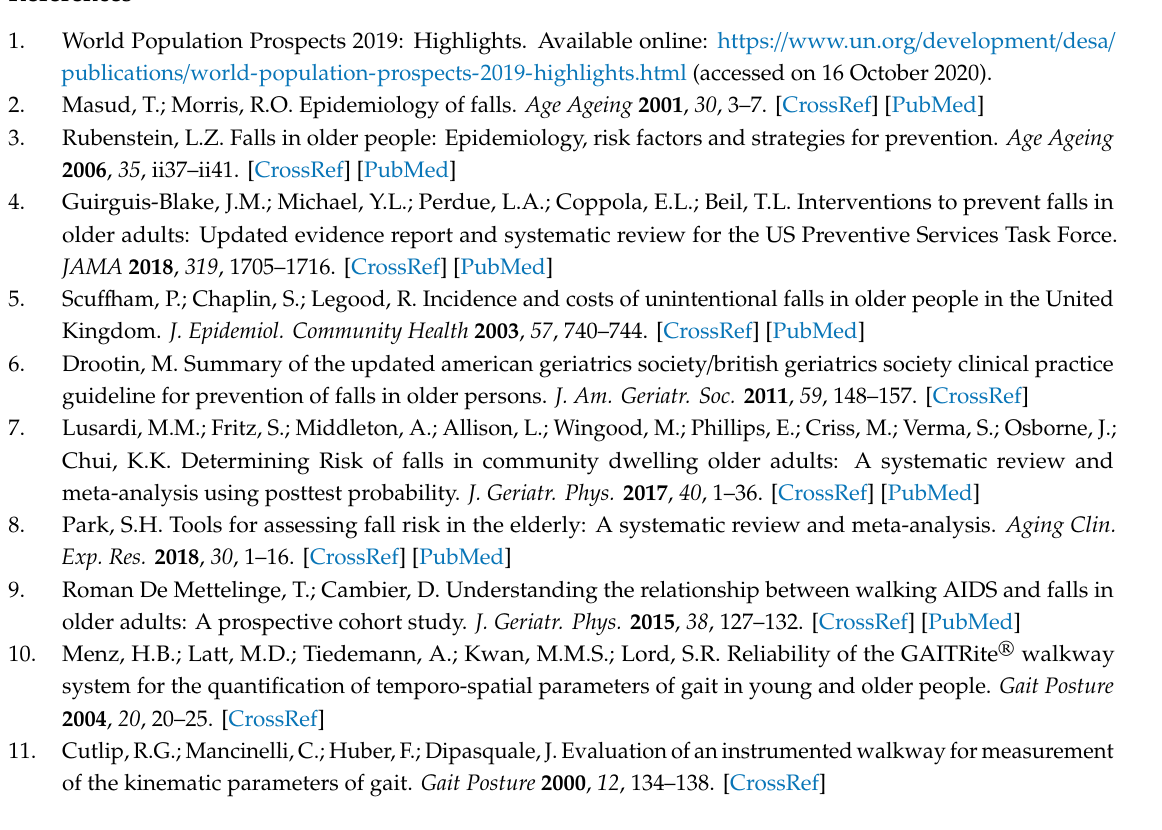
Figure S1: Correlation between GAITRite parameters and functional balance tests in patients not using walkers. Blue represents positive correlations, and red represents negative correlations. Color saturation and dot sizes represent correlation strength. Abbreviations: BBS, Bergs Balance Scale; DGI, Dynamic Gait Index; TUG, Timed Up and Go; STS, Sit To Stand test. Table S1: Correlation values between GAITRite parameters and functional balance tests in all patients. Abbreviations: BBS, Bergs Balance Scale; DGI, Dynamic Gait Index; TUG, Timed Up and Go; STS, Sit To Stand test. Table S2: Correlation values between GAITRite parameters and functional balance tests in patients using walkers. Abbreviations: BBS, Bergs Balance Scale; DGI, Dynamic Gait Index; TUG, Timed Up and Go; STS, Sit To Stand test. Table S3: Correlation values between GAITRite parameters and functional balance tests in patients not using walkers. Abbreviations: BBS, Bergs Balance Scale; DGI, Dynamic Gait Index; TUG, Timed Up and Go; STS, Sit To Stand